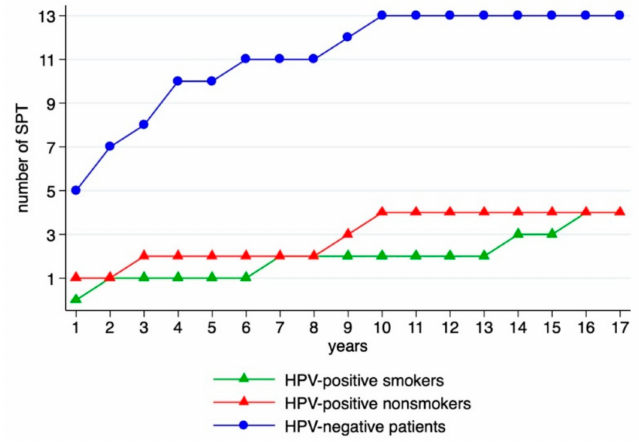
Figure 1. Distribution of SPT over time.